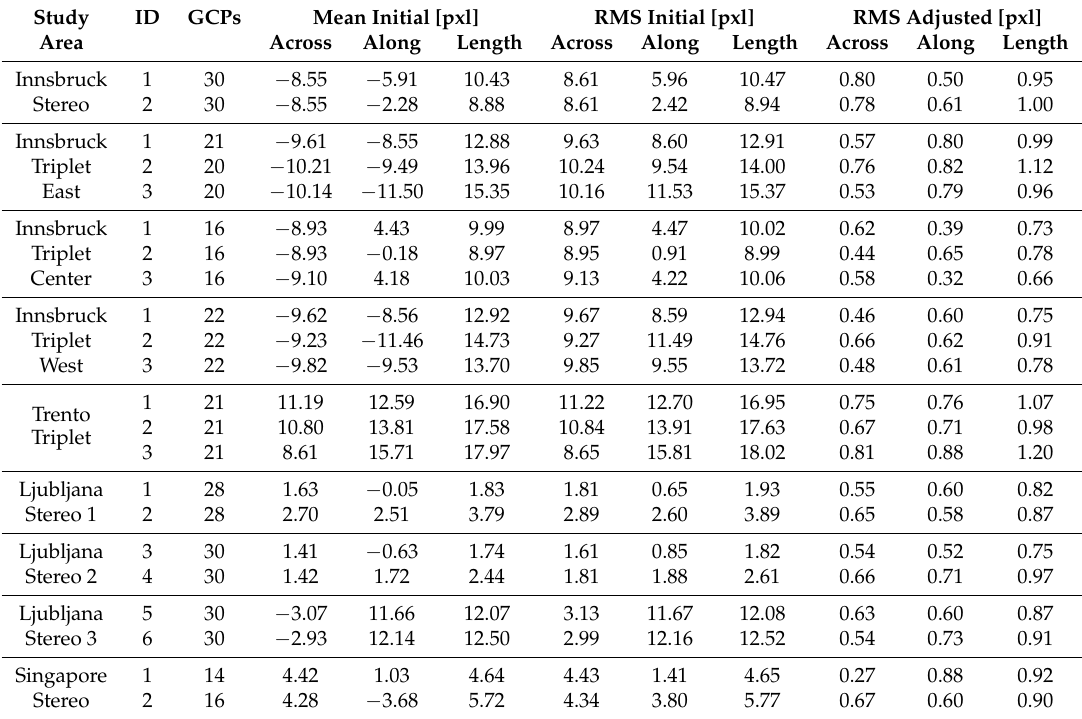
Table 3. 2D geo-location accuracy of Pléiades image data given in pixels. Shown are the initial (a-priori) mean and RMS residual errors and the RMS after parameter adjustment. Along Length Across Along Length Across Along